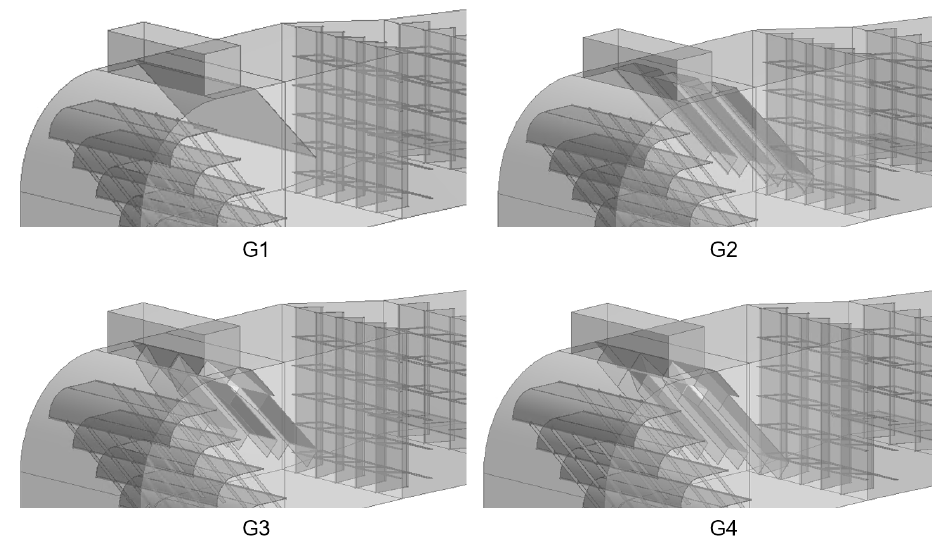
Figure 3. The four geometric variants developed, numbered from G1 to G4.